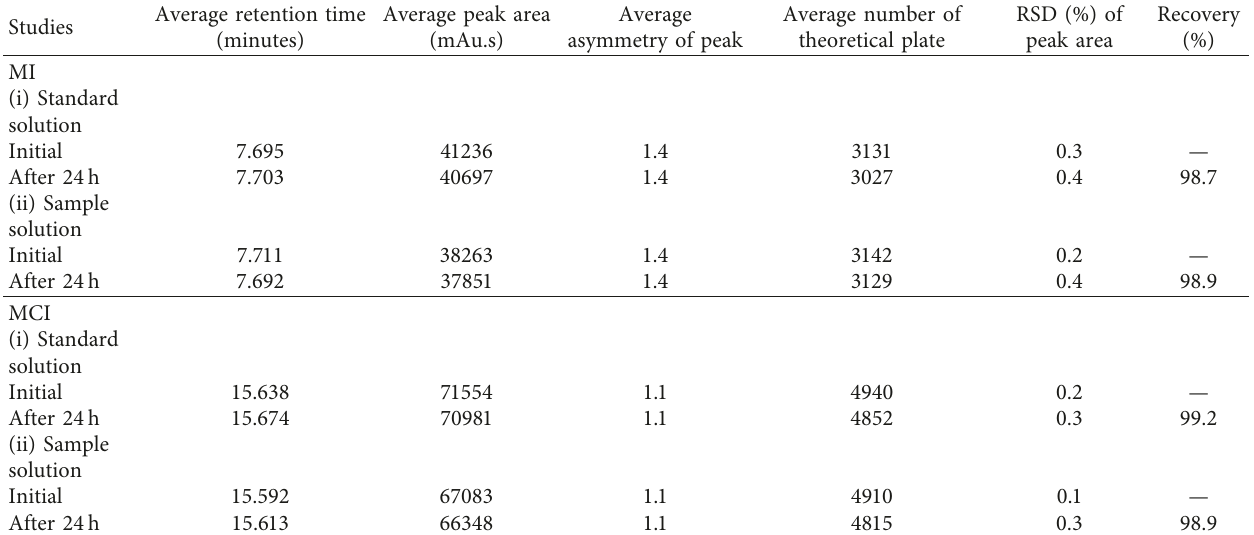
Table 8: Results of stability